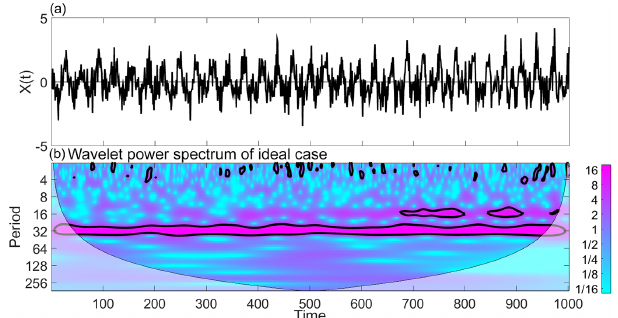
Figure 4. (a) Time series corresponding to Eq. (20). (b) Corre- sponding wavelet power spectrum.